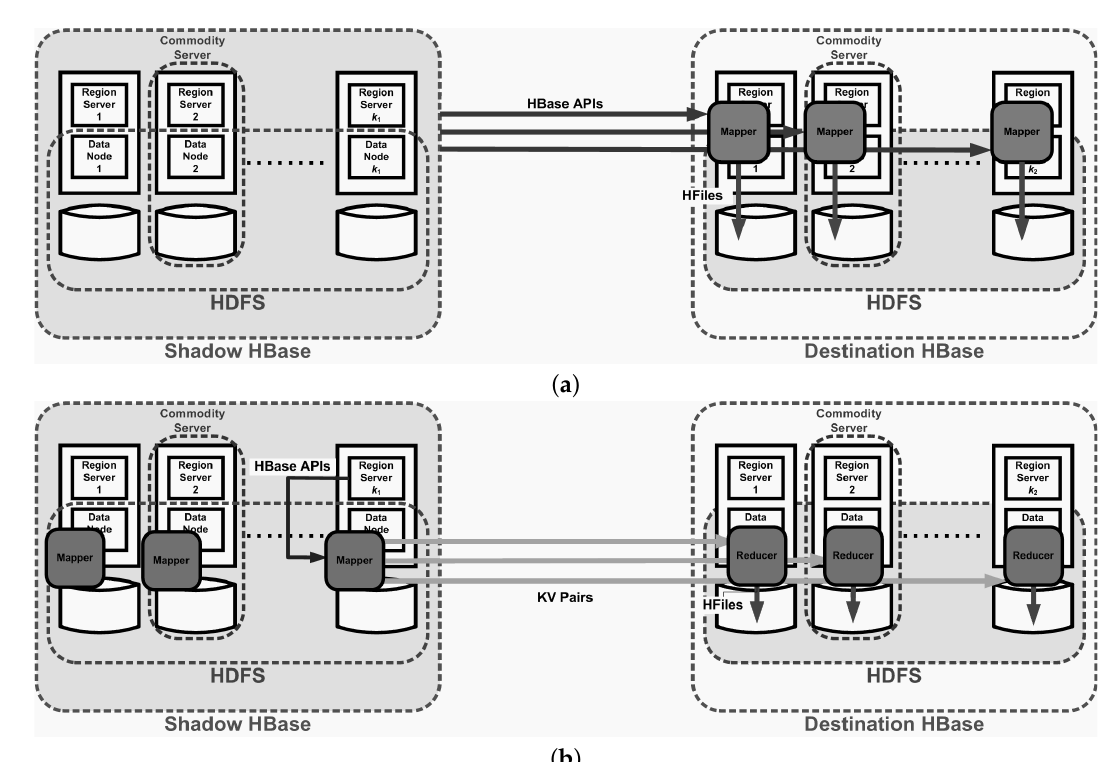
Figure 3. ( a ) The mapper-based architecture and ( b ) the mapreduce-based architecture (Gray areas are major components that are involved in the recovery